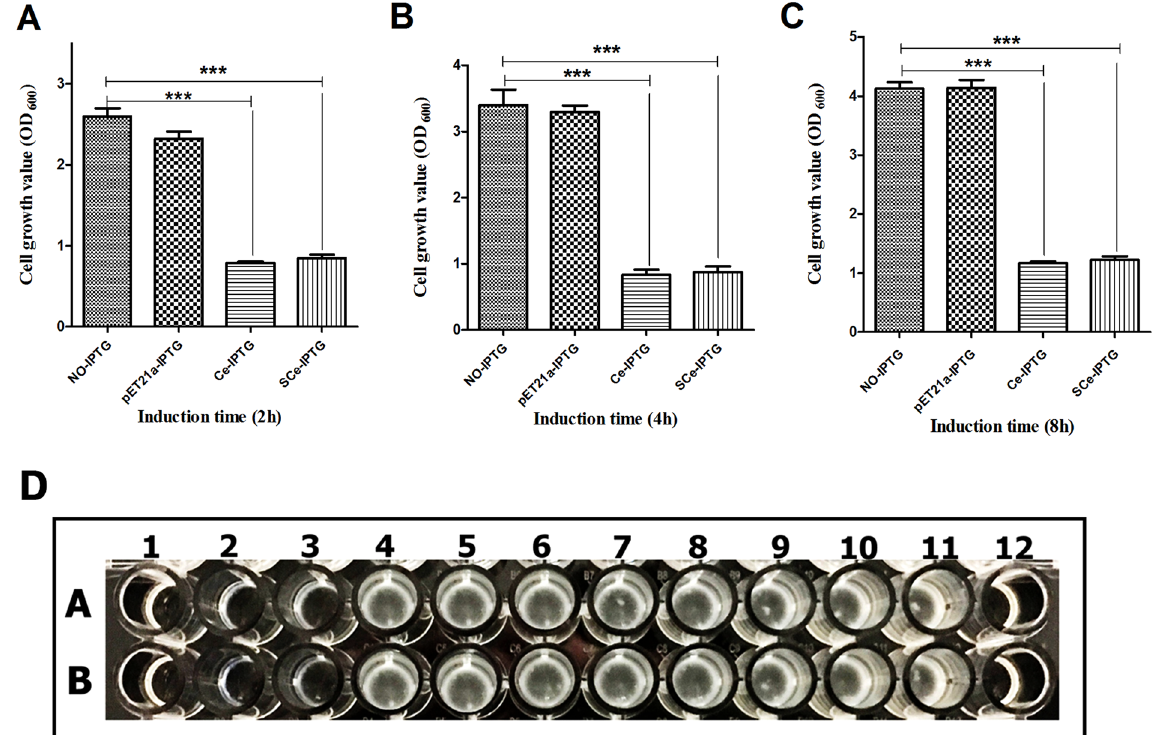
Figure 8. Growth of cells expressing Ce and SCe and inhibition concentration tests of E. coli ATCC 25922 . ( A – C ): Growth of cells expressing Ce and SCe; E. coli BL21 (DE3) cells harboring plasmids encoding peptides Ce or SCe were cultured at 37 °C, and cells were induced with 1 mM IPTG when OD 600 reached 0.8. Cell growth was monitored by OD 600 . The y-axis indicates the OD 600 ; the x-axis indicates the time after the cells were induced with IPTG. Ce: Cecropin A peptide; SCe: cecropin A peptide with the extra N-terminal amino acid residues; No-IPTG: cells were not induced with IPTG; pET21a-IPTG: cells harboring plasmid pET21a were induced with IPTG (negative control). Ce-IPTG: cells harboring Ce peptide were induced with IPTG; SCe-IPTG: cells harboring the plasmid encoding the SCe peptide were induced with IPTG. *** p < 0.001. ( D ): Inhibition concentration tests of E. coli ATCC 25922 ; a: Bioproduced cecropin A peptide; b: chemically synthesized cecropin A peptide. Wells 1 to 10 represent concentrations of peptide: 280, 140, 70, 35, 17.5, 8.75, 4.375, 2.188, 1.094, and 0.547 ng/ µ l. 11. Growth control (broth with bacterial inoculum without antibiotic); 12. Sterilized control (broth